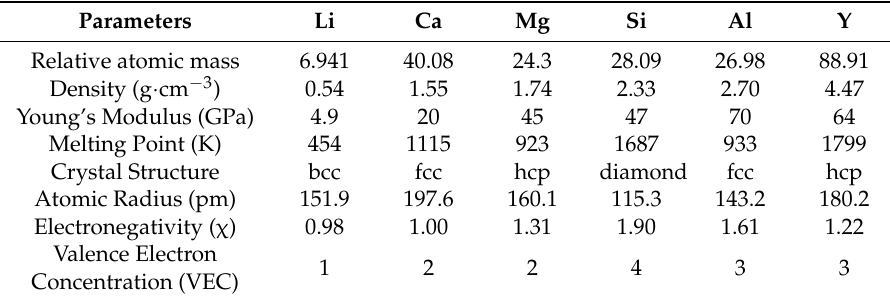
Table 1. The physical and chemical parameters of selected